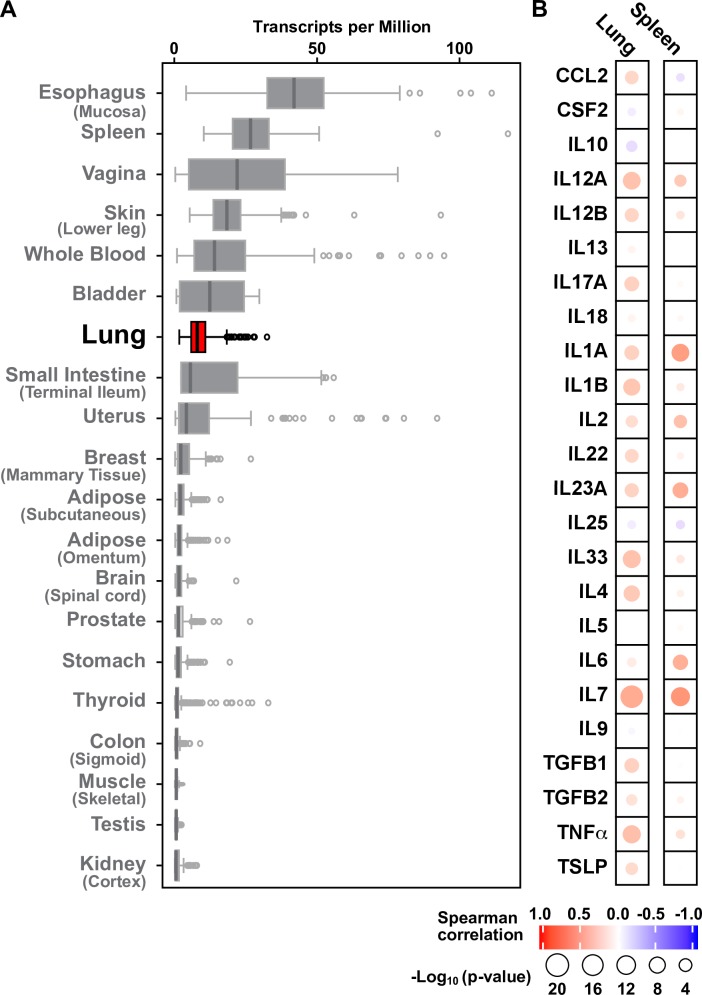
Tissue expression pattern of DAPP1 and relationship to inflammatory genes in humans.A) Levels of DAPP1 mRNA, expressed as transcripts per million reads (TPM), are highest in mucosal and immune system-related tissues, including lung (shown in red). Data were obtained from the Genotype-Tissue Expression (GTEx) project portal. B)
DAPP1 expression in lung and spleen is strongly and positively correlated with several pro-inflammatory cytokines relevant to asthma, including IL1A, IL7, IL12A, IL17A, IL23A, and IL33. The color-range in the illustration reflects the strength of the Spearman correlation coefficients (r) and the size of the circles reflects the significance levels of the p-values.